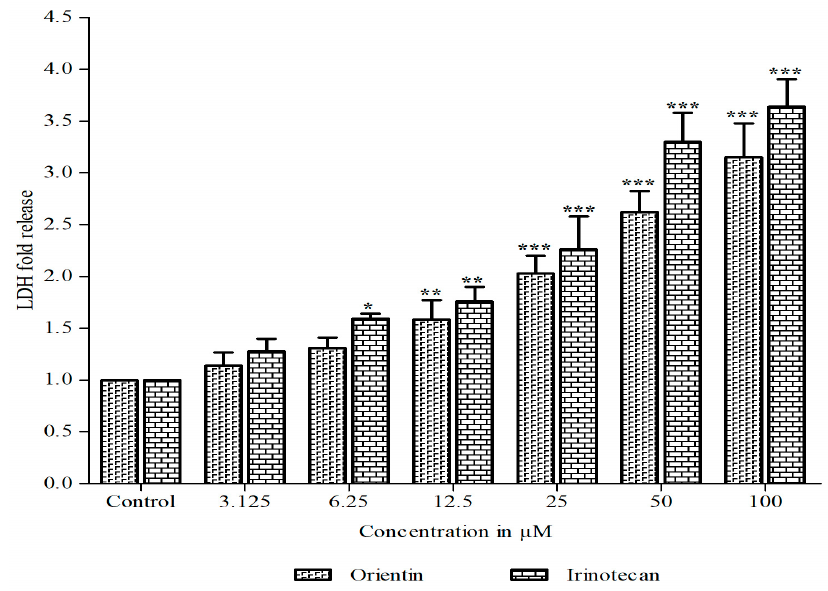
Figure 2. Effect of orientin on lactate dehydrogenase (LDH) release. The release of LDH in HT-29 cells treated with different concentration of orientin and irinotecan for 24 h. Results are expressed as the mean ± SD of three independent experiments. * p < 0.05, ** p < 0.01 and *** p < 0.001 vs. control.